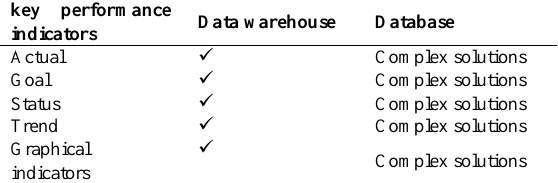
Table 3. Key-performance